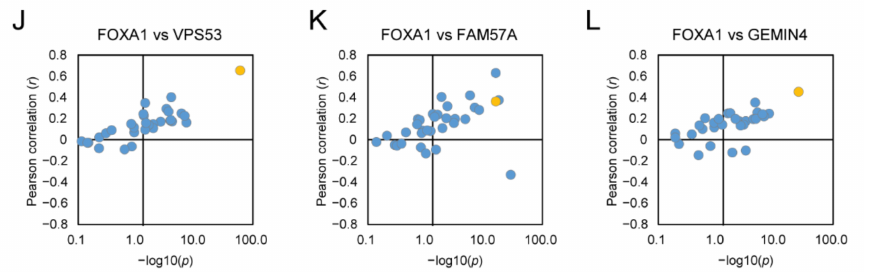
Figure 5. rs684232 regulates gene expression of VPS53 , FAM57A , and GEMIN4 through FOXA1. ( A ) The location of the rs684232 relative to three target genes. ( B – D ) eQTL analysis in GTEx prostate tissues to reveal the association between alleles of rs684232 and VPS53 ( B ), FAM57A ( C ), and GEMIN4 ( D ) genes. p values are from a linear regression model. ( E ) Gene expression quantification of VPS53, FAM57A , and GEMIN4 by RT-qPCR in three 22Rv1 cells, including parental 22Rv1 cells and mutated cells 22Rv1( − / − ) #1/ #2. Mean ± SEM of three biological replicates. ** p < 0.01, *** p < 0.001, two-tailed Student’s t -test. ( F ) Gene expression quantification of VPS53, FAM57A, and GEMIN4 by RT-qPCR in 22Rv1 cells treated with FOXA1 shRNA. Mean ± SD of three technical replicates. * p < 0.05, *** p < 0.001, two-tailed Student’s t -test. ( G – I ) Gene expression correlation analysis between transcription factor FOXA1 and the three target genes VPS53 ( G ), FAN57A ( H ), and GEMIN4 ( I ) in prostate tumor tissues from TCGA-PRAD database. Correlation coefficient ( r ) values and p values were from Pearson or Spearman correlation analysis, respectively. ( J – L ) Gene expression correlation analysis between FOXA1 and VPS53 ( J ), FAM57A ( K ), or GEMIN4 ( L ) in 33 kinds of cancer tissues from TCGA. The Pearson correlation coefficient value of each cancer type was plotted vs. the − log10 of p -value. The dot in yellow represents the PRAD. Correlation coefficient ( r ) values and p values were from the Pearson correlation